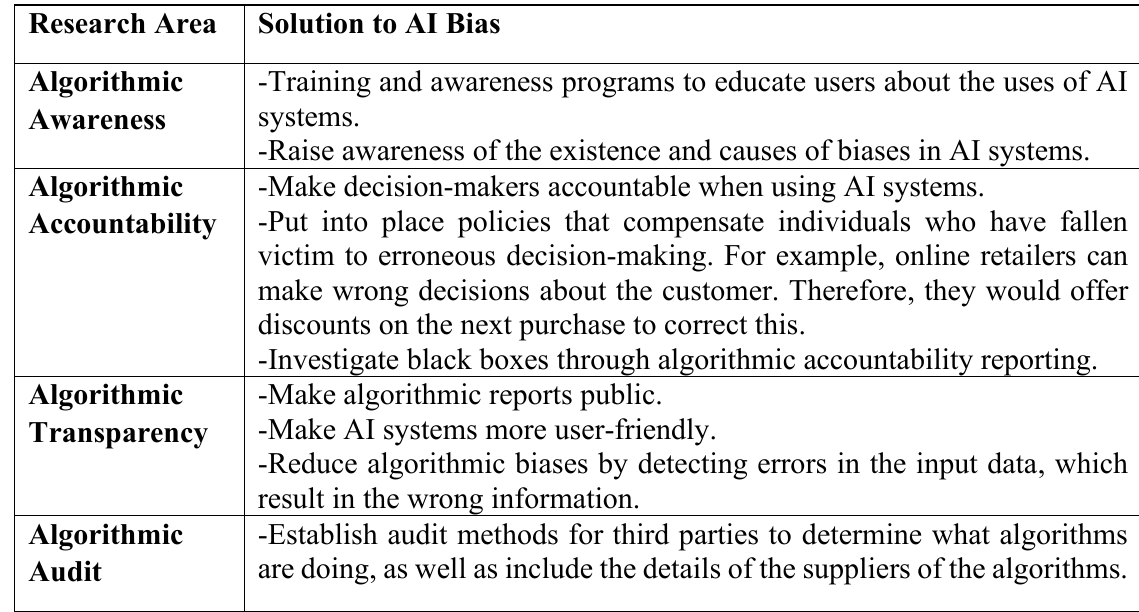
Table 2 highlights four ways of addressing AI biases. TABLE 2: RESEARCH AREAS ON MANAGING AI